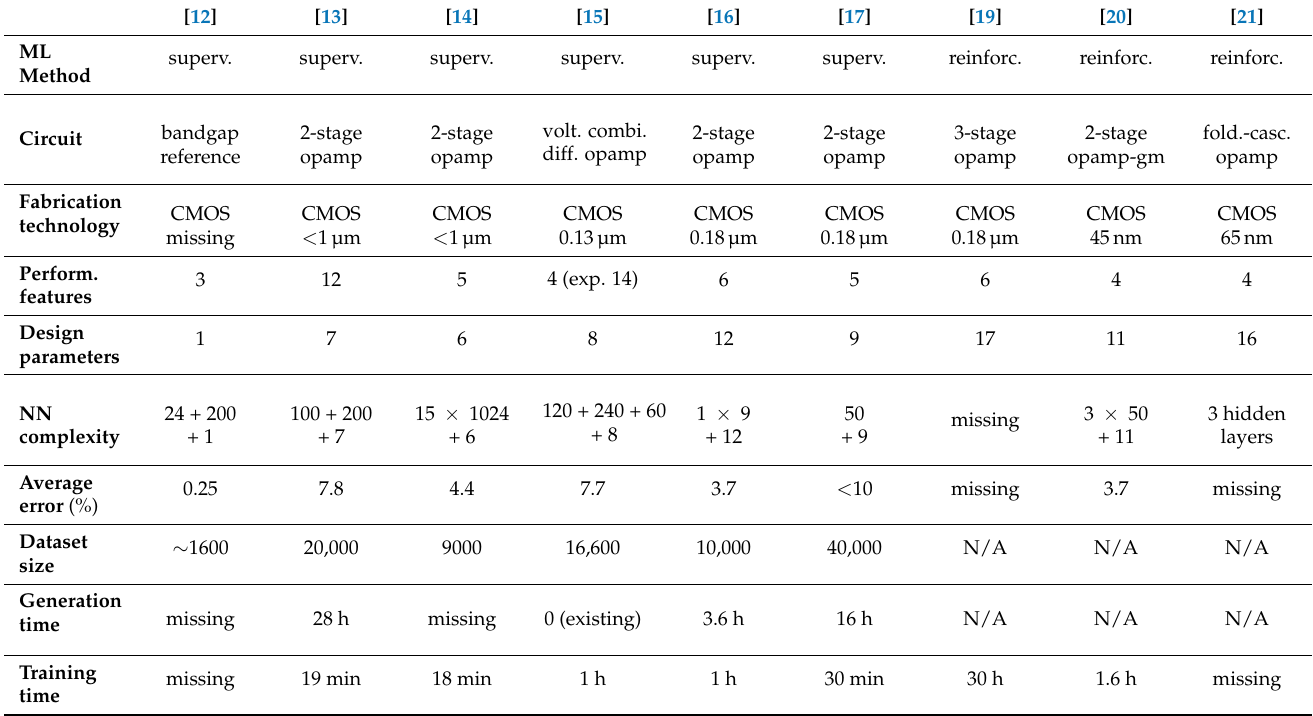
Table 5. Comparative summary of supervised and reinforcement learning techniques in the prior